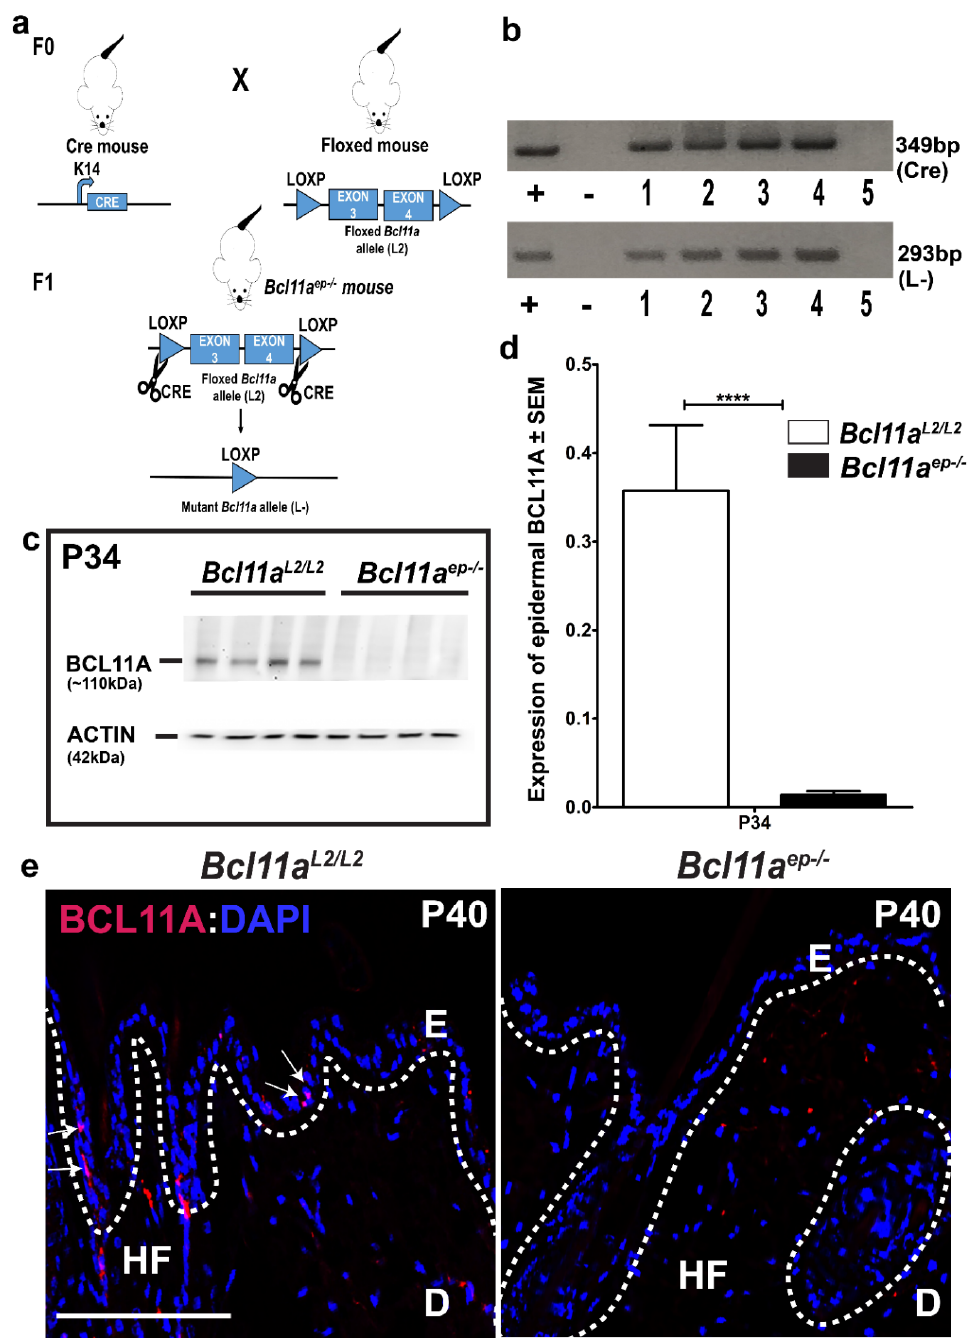
Figure 1. Confirmation of epidermal specific Bcl11a excision in Bcl11a ep − / − mice. ( a ) Schematic representation of Cre-LoxP mediated generation of Bcl11a ep − / − mice. ( b ) PCR amplification of Cre and L- (excision) alleles on tail DNA extracted from Bcl11a L2/L2 and Bcl11a ep − / − mice. “+” and “ − ” indicates positive and negative control with PCR being performed on isolated DNA from pre- confirmed Bcl11a ep − / − mice and Milli-Q water, respectively. 1,2,3,4,5 represent mouse ID numbers (either Bcl11a L2/L2 or Bcl11a ep − / − ) from which the tail tip was harvested for subsequent DNA extraction and PCR. ( c ) Immunoblot analysis of epidermal protein extracts from postnatal day 34 (P34) tail skin samples using anti-BCL11A monoclonal antibody. β -actin was used as the internal control. ( d ) Bar graph quantification of P34 epidermal BCL11A expression in wildtype ( Bcl11a L2/L2 ) versus mutant ( Bcl11a ep − / − ) mice. ( e ) IHC of 5- µ m thick dorsal skin sections with anti-BCL11A antibody (red)